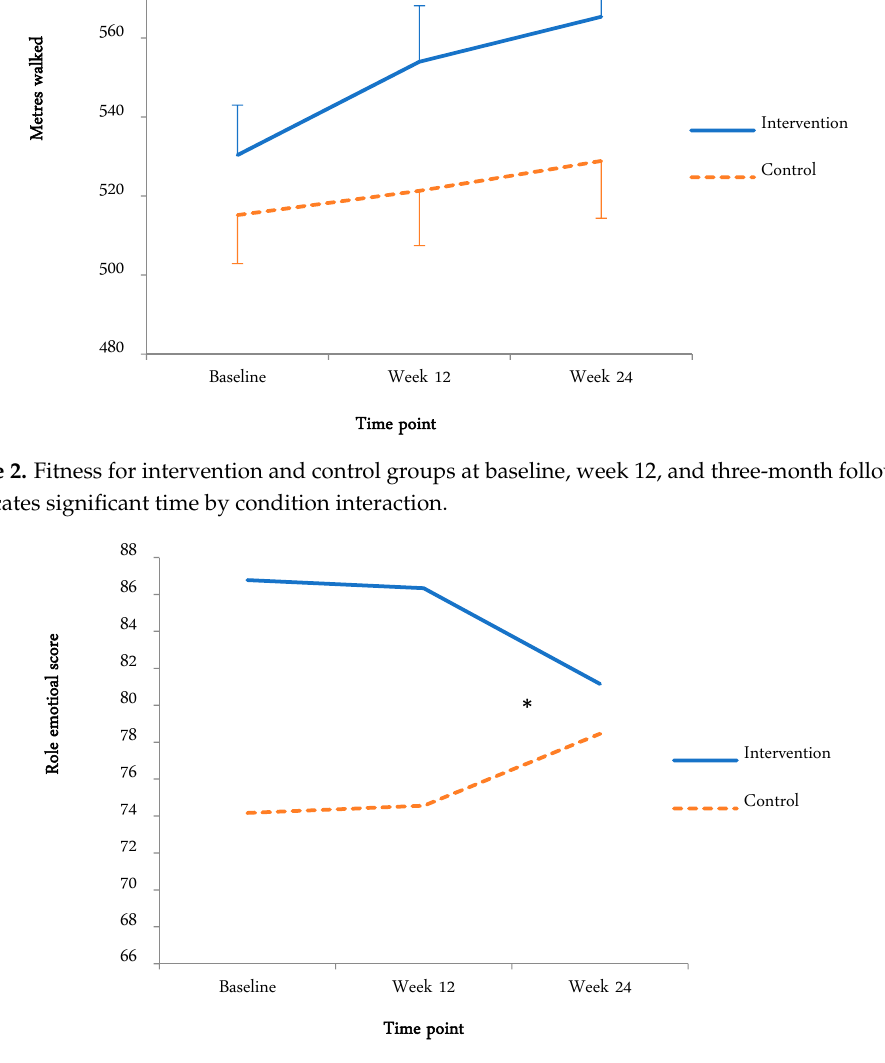
Figure 3. Role emotional score for intervention and control groups at baseline, week 12, and three-month follow-up. * Indicates significant time by condition interaction.